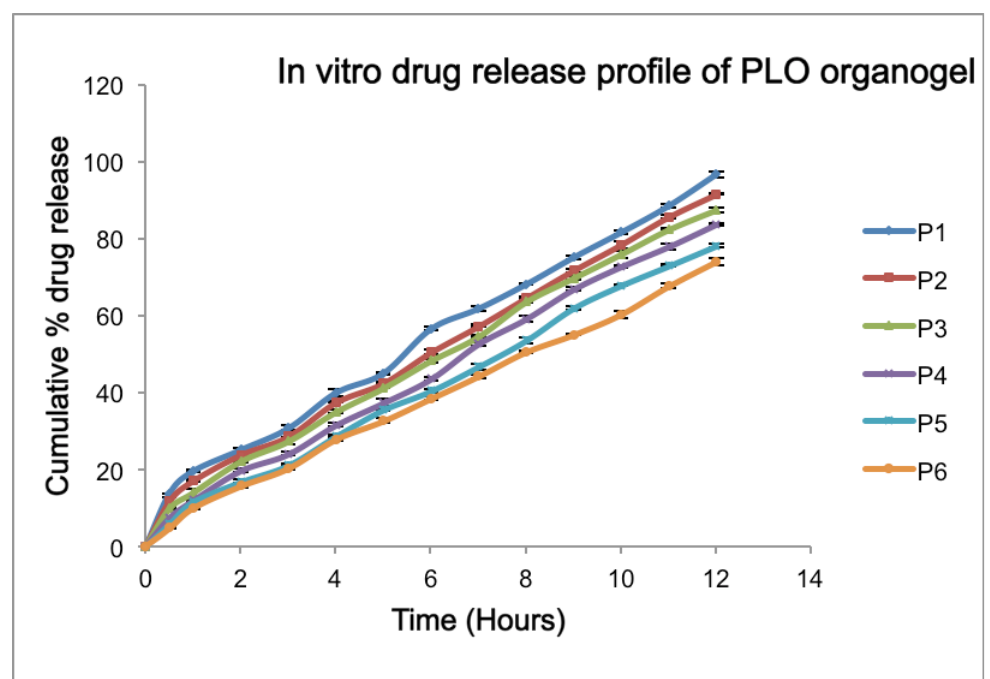
FIGURE 9 - Drug release profile of pluronic lecithin organogel in phosphate buffer of pH 7.4 as a function of hours.